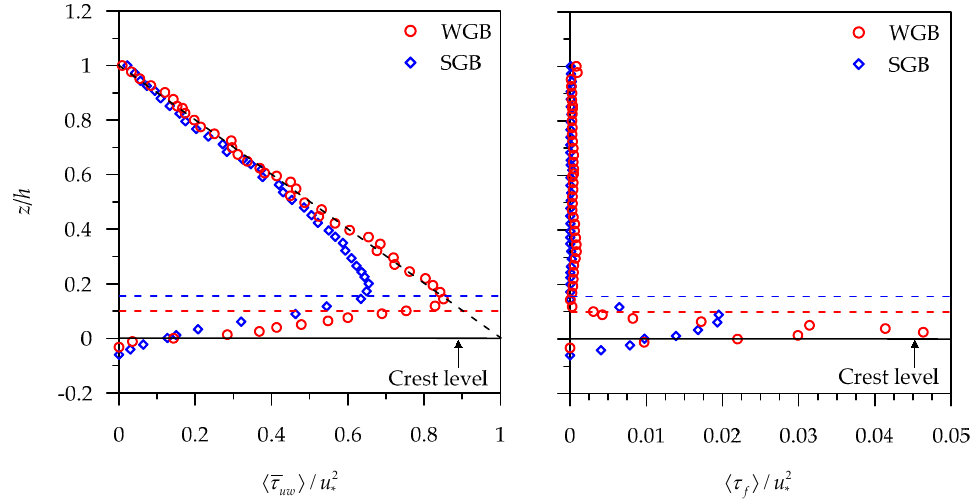
Figure 9. Variations of non-dimensional SA Reynolds shear stress (cid:104) τ uw (cid:105) / u 2 ∗ and SA form-induced shear stress (cid:104) τ f (cid:105) / u 2 ∗ with non-dimensional vertical distance z / h in the WGB and SGB (data extracted from Padhi et al. [32]).